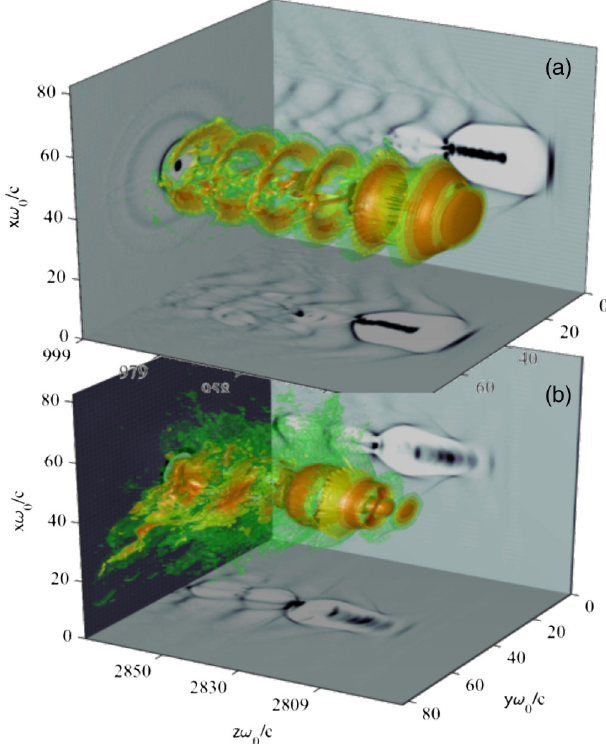
and y – z planes. At (a) z ¼ 0 . 92 mm, (b) z ¼ 2 . 8